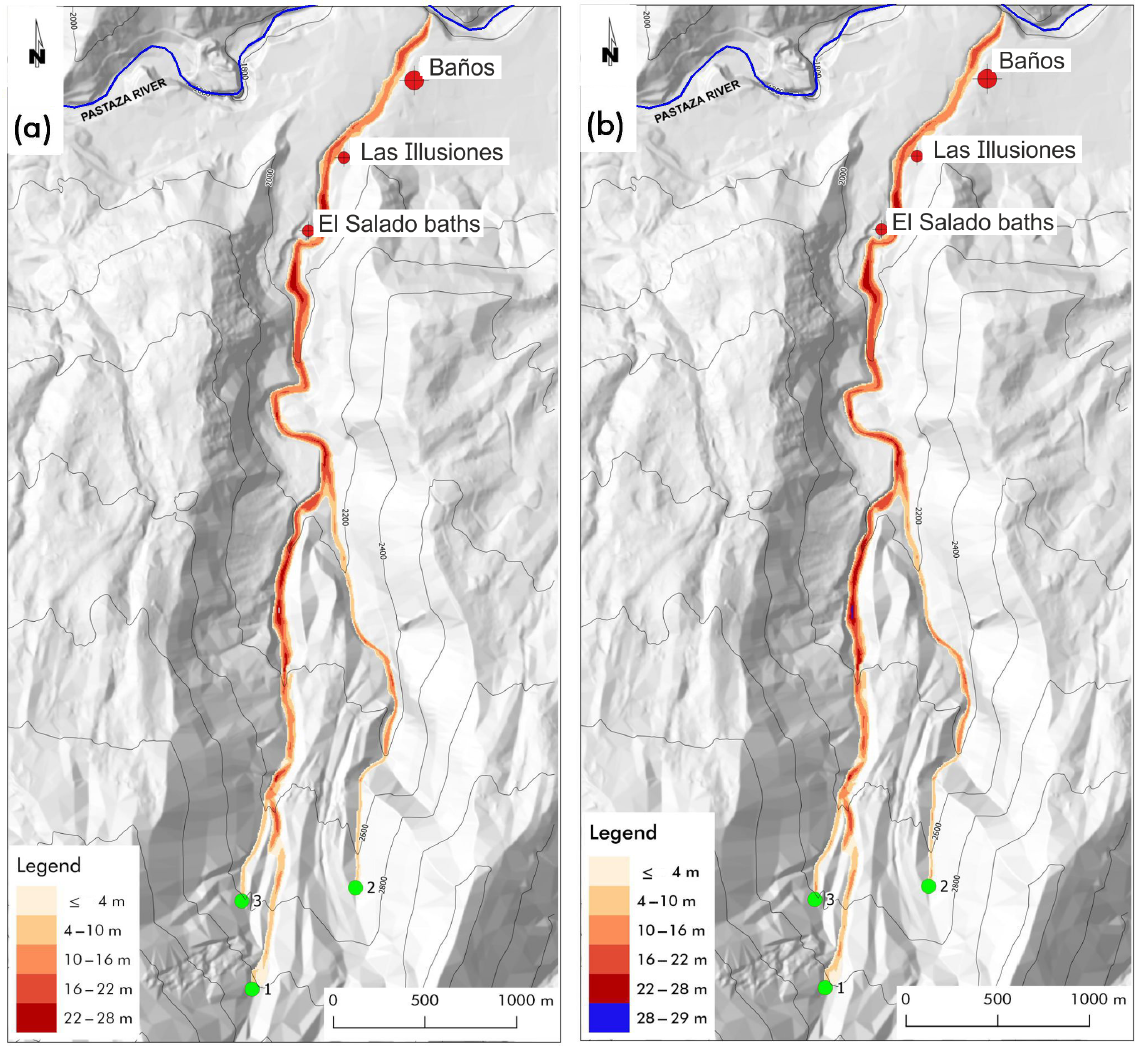
Figure 12. Simulations of simultaneous triggering of lahars generated in point 1, 2, and 3: in panel (a) with total detachment volume of 13625m 3 and in panel (b) with total detachment volume of 27250m 3 . The legend specifies the maximum thickness of the lahar reached during the conjectured events for each point